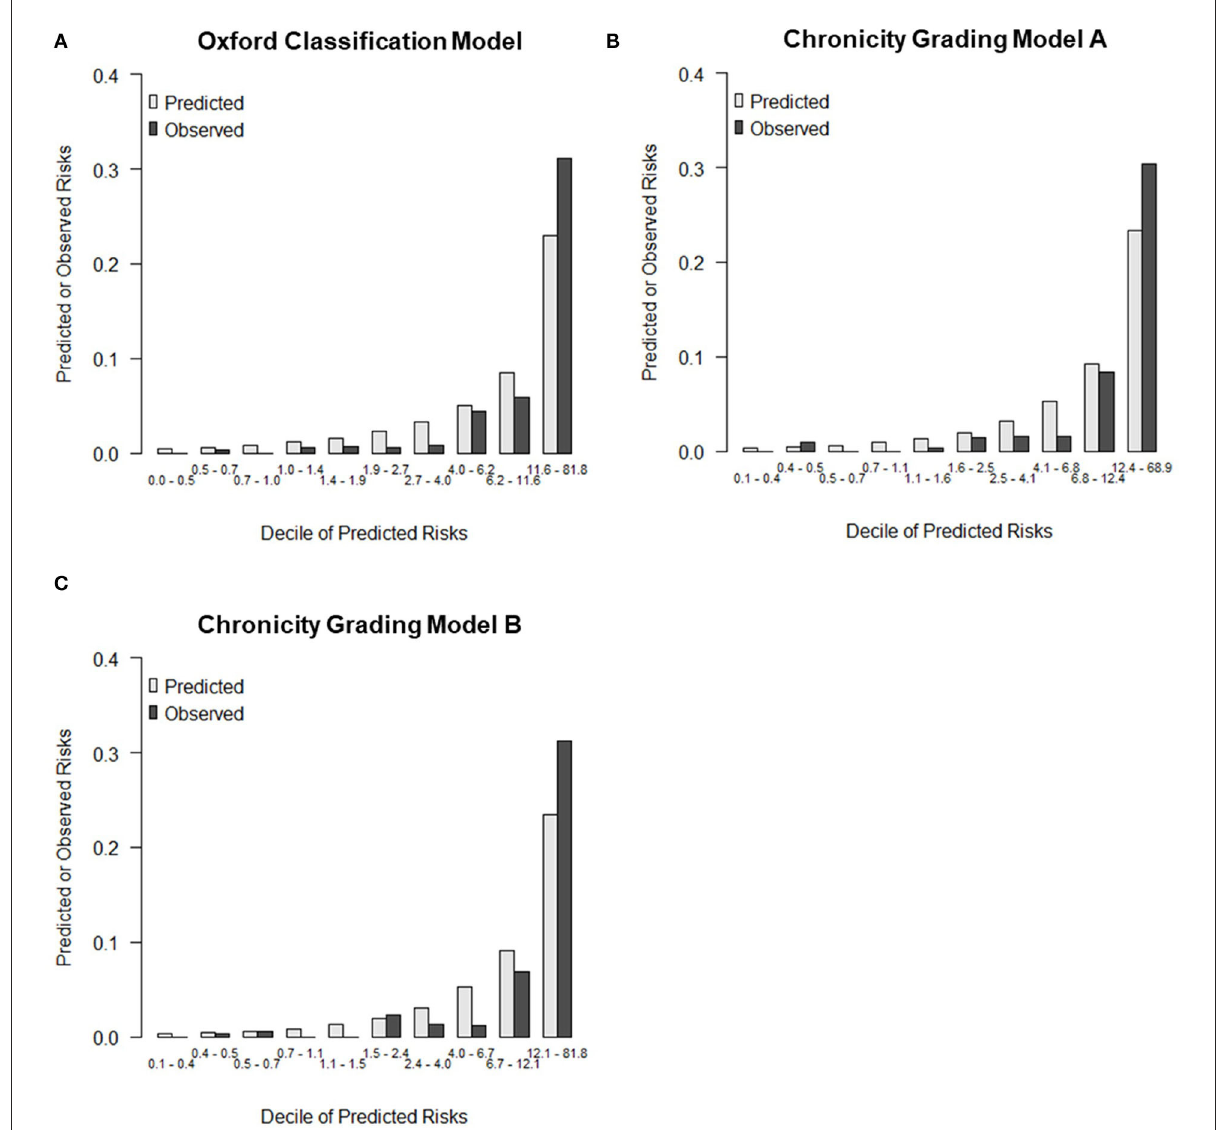
FIGURE2 Calibration plot for predicted vs. observed 5-year risks of the primary renal outcome. (A) Calibration plots by deciles of predicted risk for Oxford classification model, (B) Chronicity grading model A, and (C) Chronicity grading model